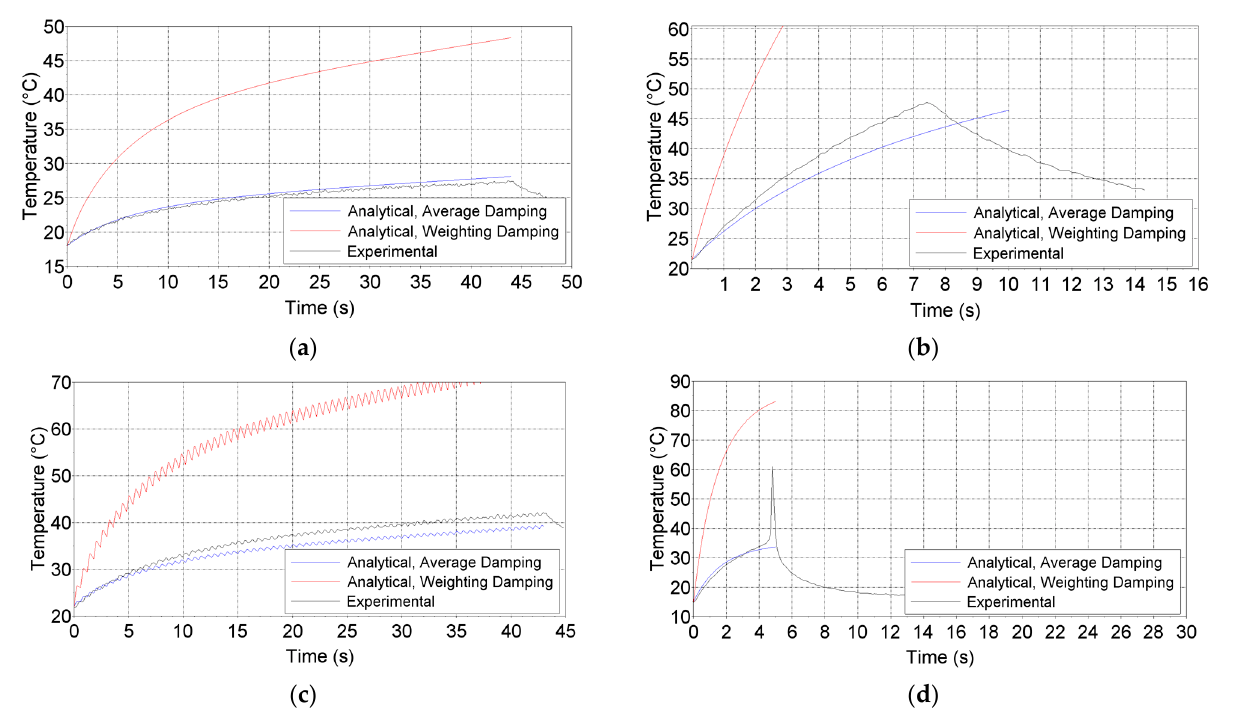
Figure 23. Experimental and computational model temperature comparison, 51CrV4 steel, UHCF specimen: ( a ) maximum stress = 200 MPa, continuous excitation; ( b ) maximum stress = 400 MPa, continuous excitation; ( c ) maximum stress = 400 MPa, t on = 0.2 s, t off = 0.4 s, 72 pulses; ( d ) maximum stress = 600 MPa, continuous excitation, forced convection, h = 1500 W/(m 2 .K), crack